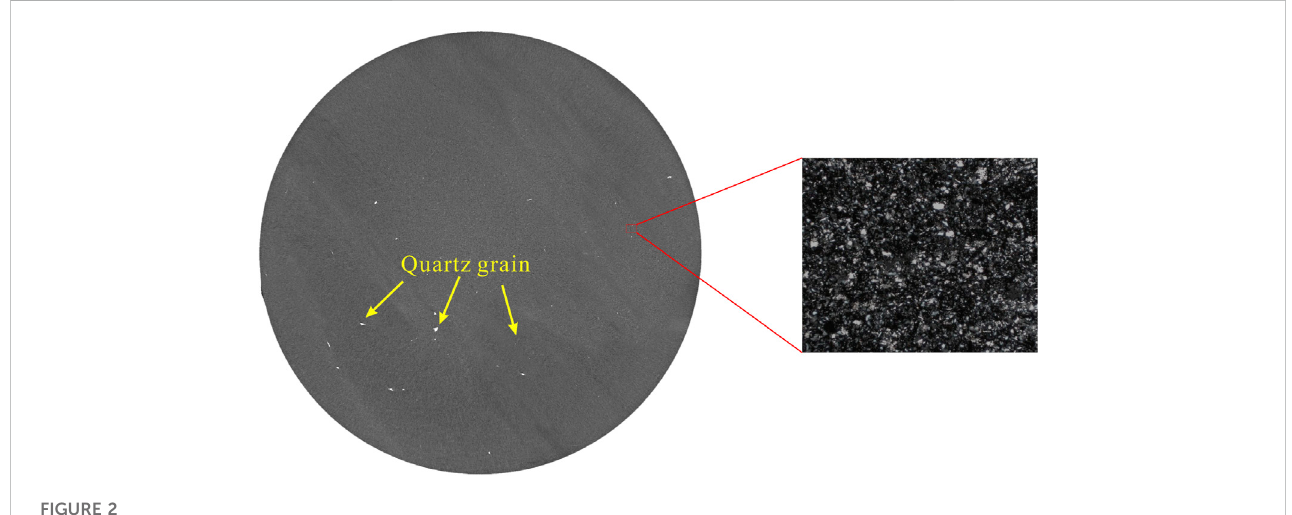
FIGURE 2 CT scanning image.